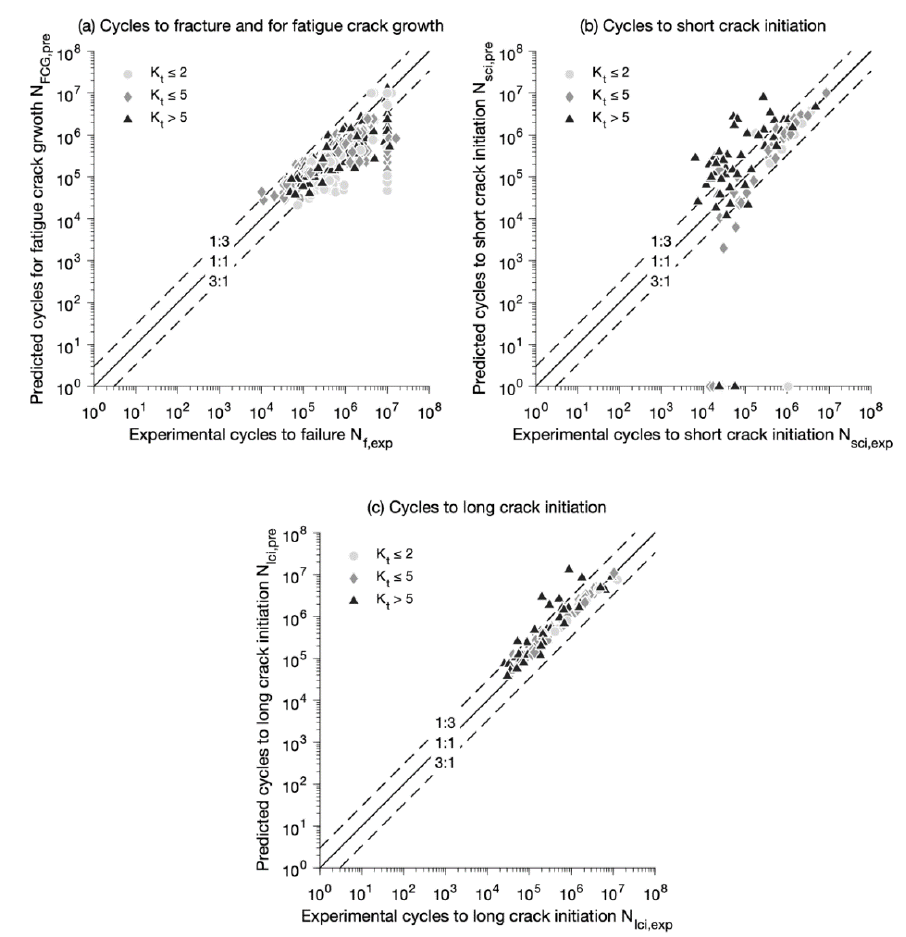
Figure 12. Comparison of ( a ) cycles to fracture and cycles for fatigue crack growth, ( b ) cycles to crack initiation, and ( c ) cycles to long crack initiation.